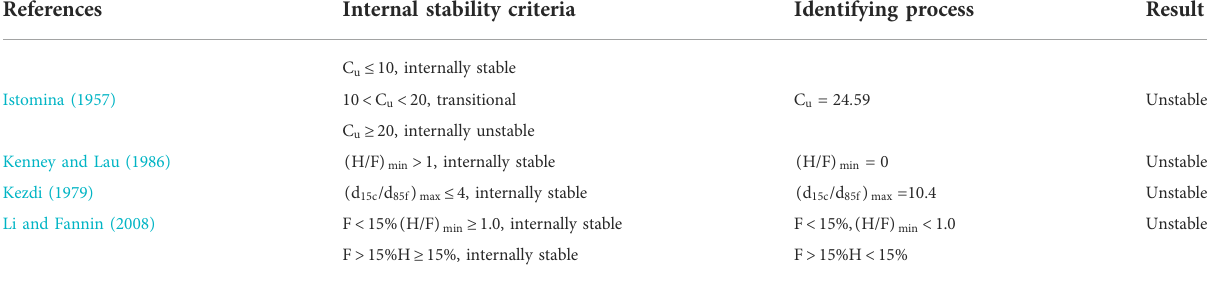
TABLE 2 Evaluation of internal instability of tested soils.